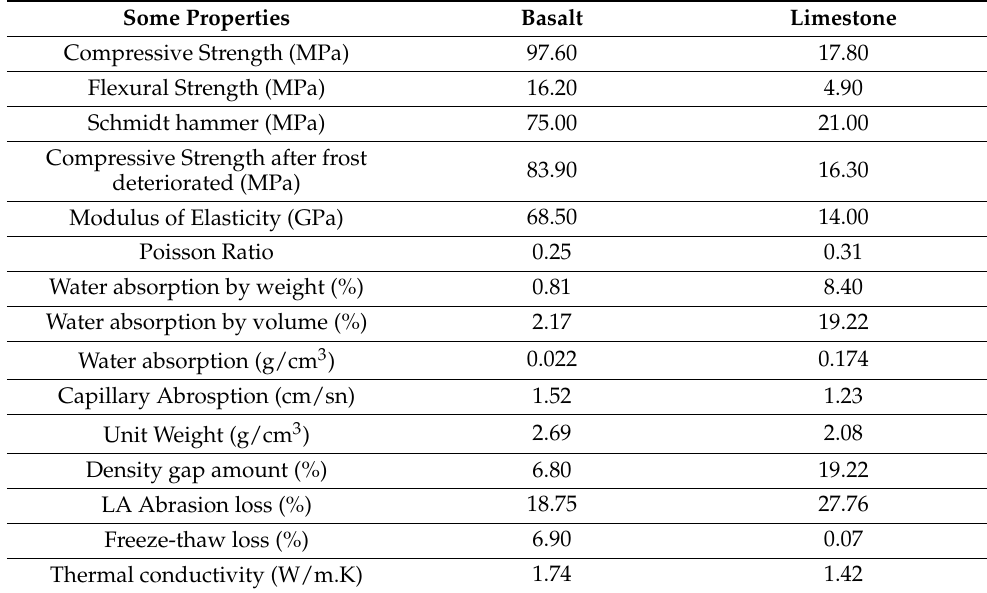
Table 1. Comparison of physical and mechanic properties of basalt with the limestone.